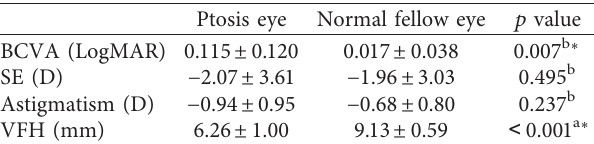
Table 1: Clinical data analysis for the eyes of the ptosis group and the normal fellow